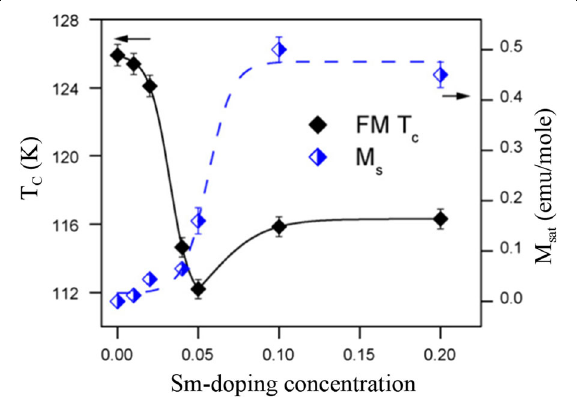
Fig. 20 Variation in saturation magnetization ( M sat ) and magnetic transition temperature ( T C ) of the Ca 1- x Sm x MnO 3 nanopowders as a function of the Sm-doping concentrations. Solid and broken lines just show the trends. Reproduced with permission of